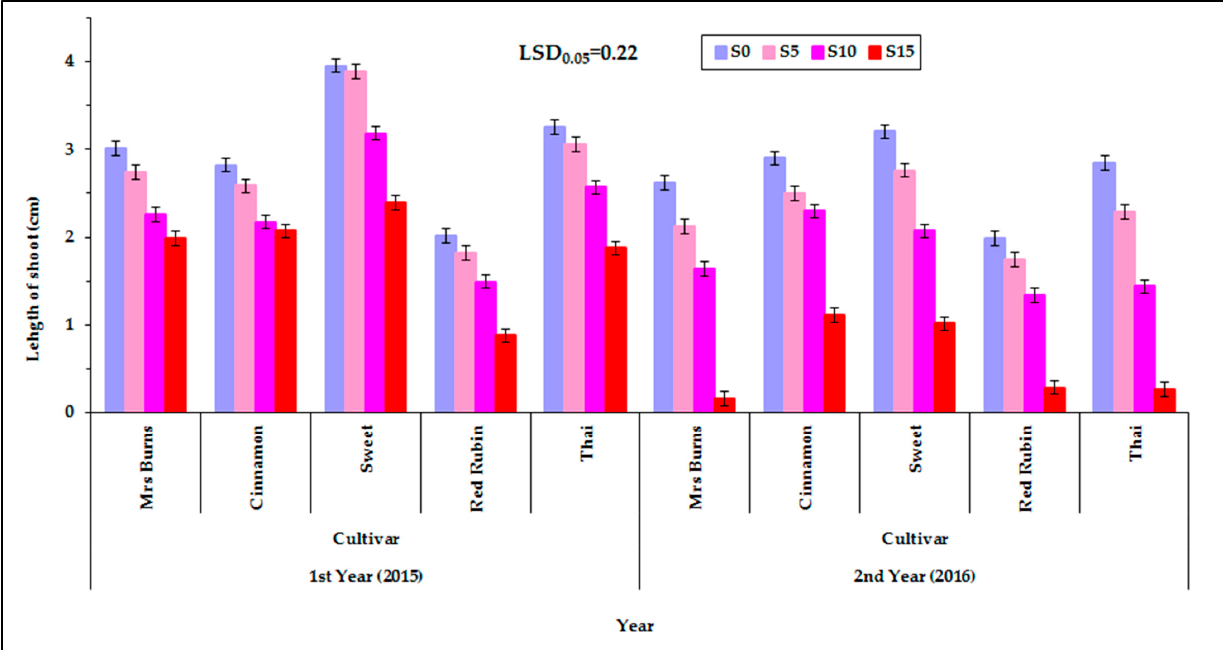
Figure 6. Shoot length of the seedling of the five basil cultivars (“Mrs Burns”, “Cinnamon”, “Sweet”, “Red Rubin” and “Thai”), at the four PEG concentrations, S 0 for 0% PEG, S 5 for 5% PEG, S 10 for 10% PEG and S 15 for 15% PEG, at the two years of experimentation. Data presented are estimated mean values averaged over the three irrigation levels. LSD is the least significant difference at the 0.05 significance level. Error bars correspond to the estimated common standard error of the mean val- ues. Each mean value has been estimated utilizing n = 12 measurements. Figure S6 (see Supplemen- tary Material) presents the observed mean values and the corresponding individual standard errors.